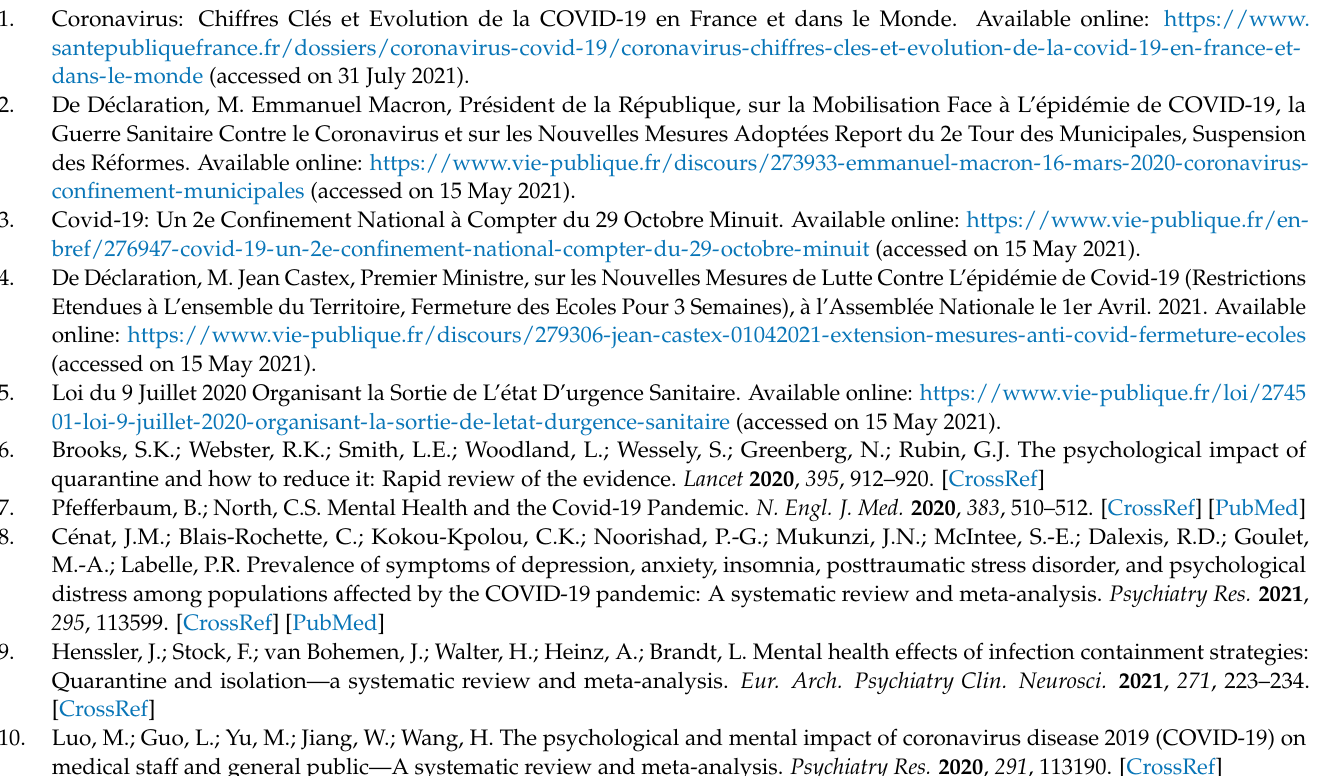
Table S2: Identification of trajectory models of loneliness trajectories, Table S3: The association of social support and loneliness trajectories with symptoms of depression and anxiety in French participants of the COMET cohort- logistic regression